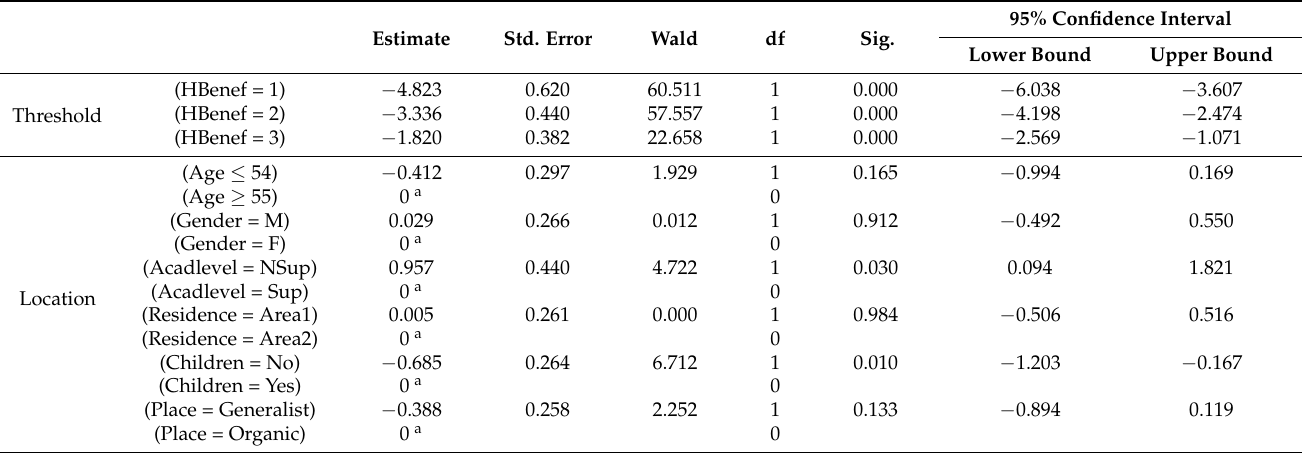
Table 6. Significance of the independent variables.